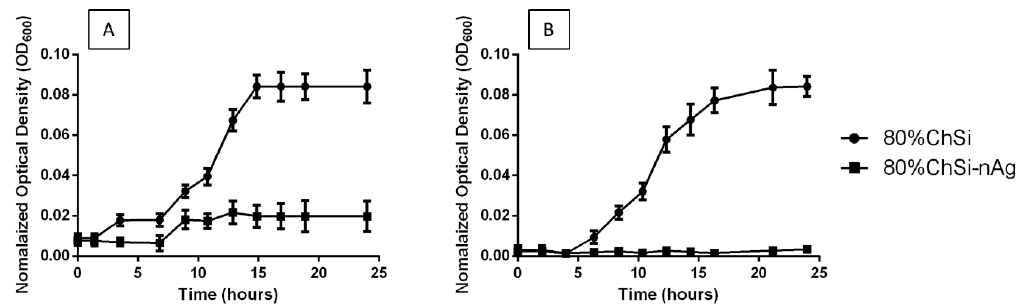
Figure 12. Inhibition of bacterial growth in planktonic cultures. There was a ( A ) marked reduction in E. coli growth and ( B ) complete inhibition of S. aureus grown in the presence of 80% ChSi-nAg compared to 80% ChSi. This inhibition of bacterial growth by 80% ChSi-nAg was representative and consistent for all hybrid coatings that contained AgNPs.